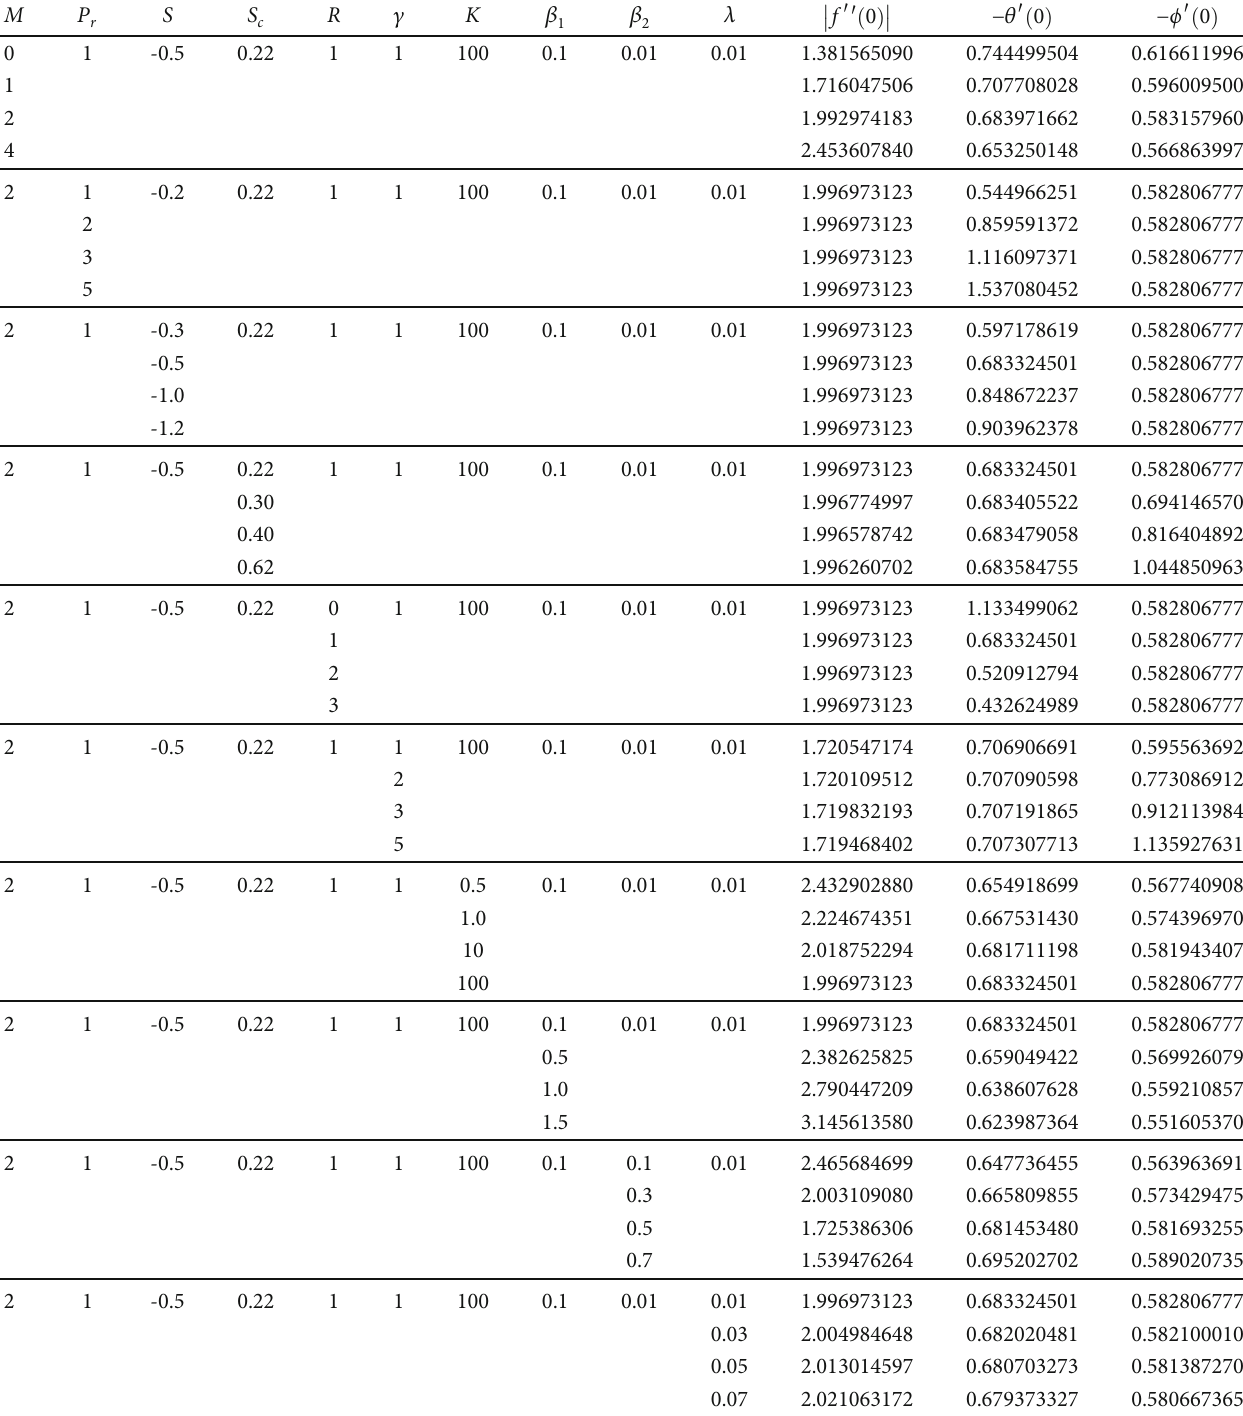
Table 5: Di ff erent values of skin friction coe ffi cient, local Nusselt number, and local Sherwood number using SLM for di ff erent material